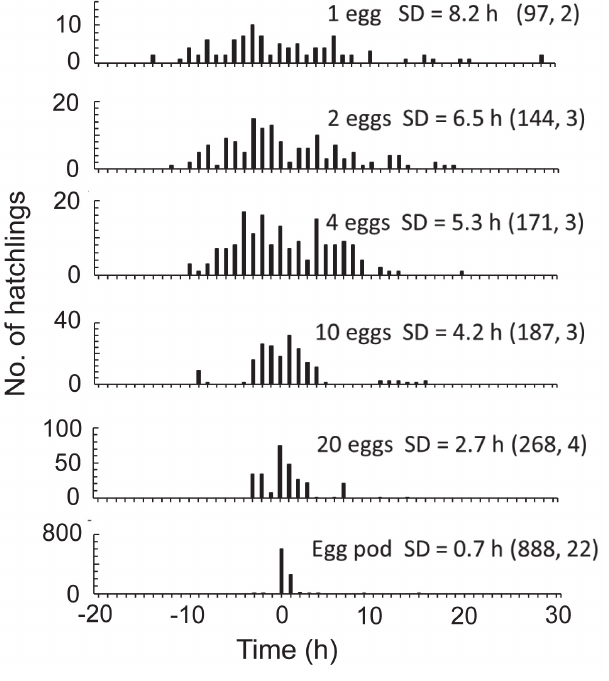
Fig. 4. The effect of egg mass sizes on the ranges of hatching times of Locusta migratoria eggs. The frequency distributions of hatching times plotted as deviations from the mean (designated as 0 h) for each egg pod tested. The data for the egg pods are the same as those given in Fig. 1B. SDs are shown. The numbers in parentheses indicate the numbers of hatched eggs and pods used.